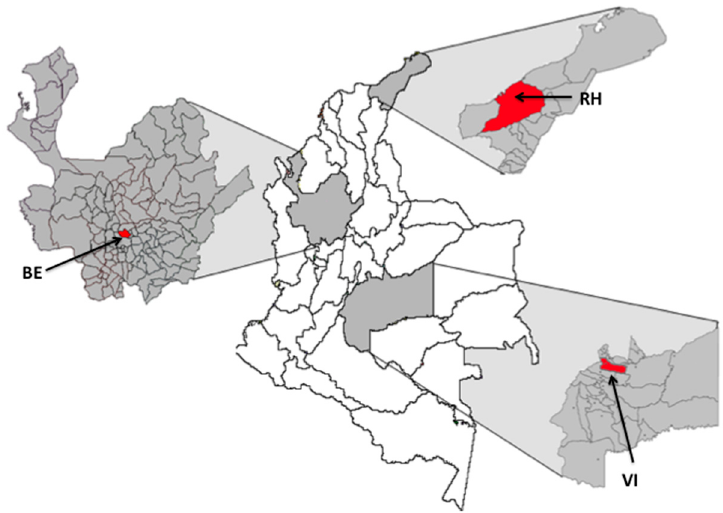
Figure 1. Map of Colombia showing cities where samples of Aedes aegypti mosquitoes were collected. BE: Bello, RH: Riohacha, and VI: Villavicencio.